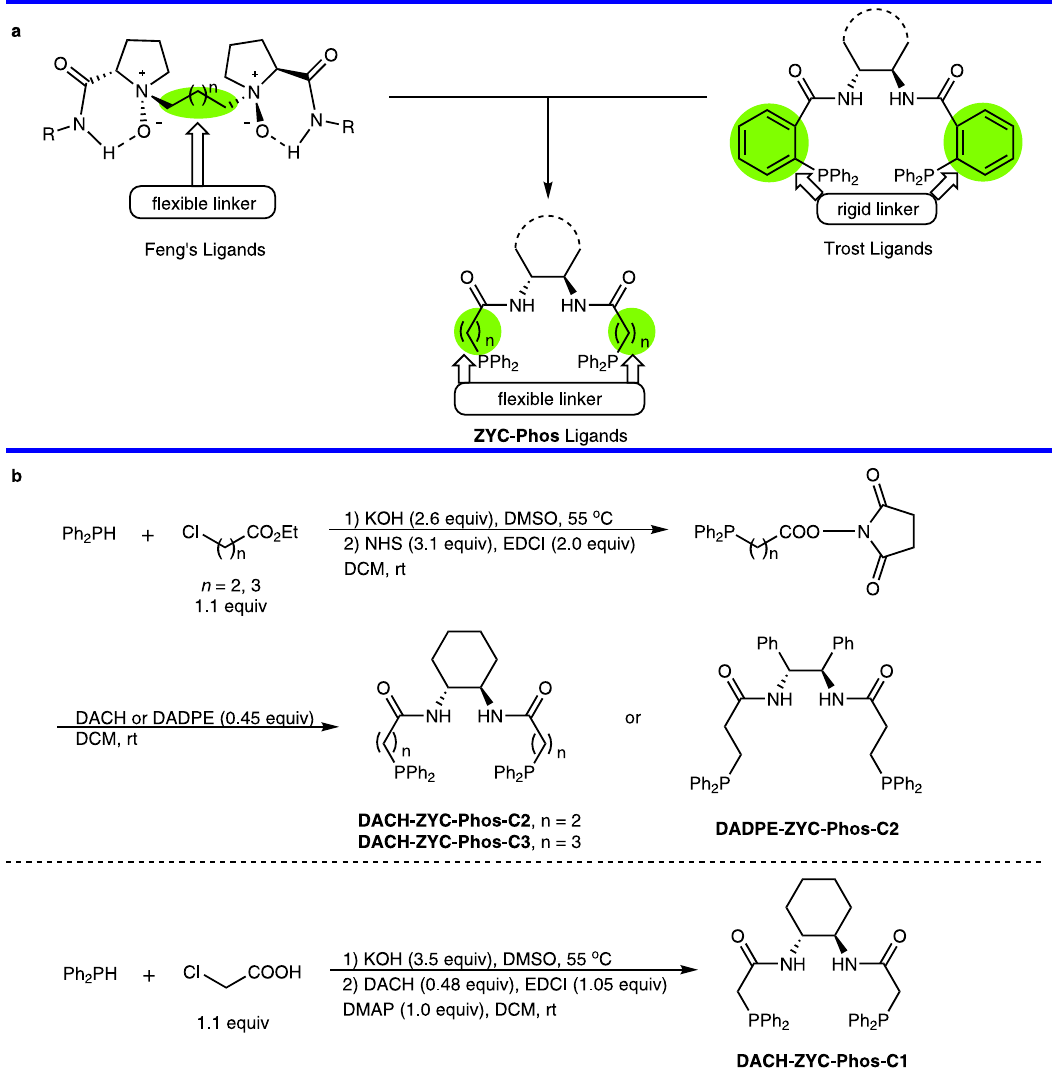
Fig. 3 Concept and synthesis of the ZYC-Phos ligands. a The concept of ZYC-Phos ligands from the Feng ’ s ligands and the Trost ligands. b The synthesis of ZYC-Phos ligands. EDCI 1-ethyl-(3-dimethylaminipropyl)carbodiimide hydrochloride, NHS N -hydroxysuccinimde, DMSO dimethyl sulfoxide, DCM dichloromethane, DACH (1 R ,2 R )-1,2-diaminocyclohexane, DADPE (1 R ,2 R )-1,2-diphenyl-1,2-diaminoethane, DMAP